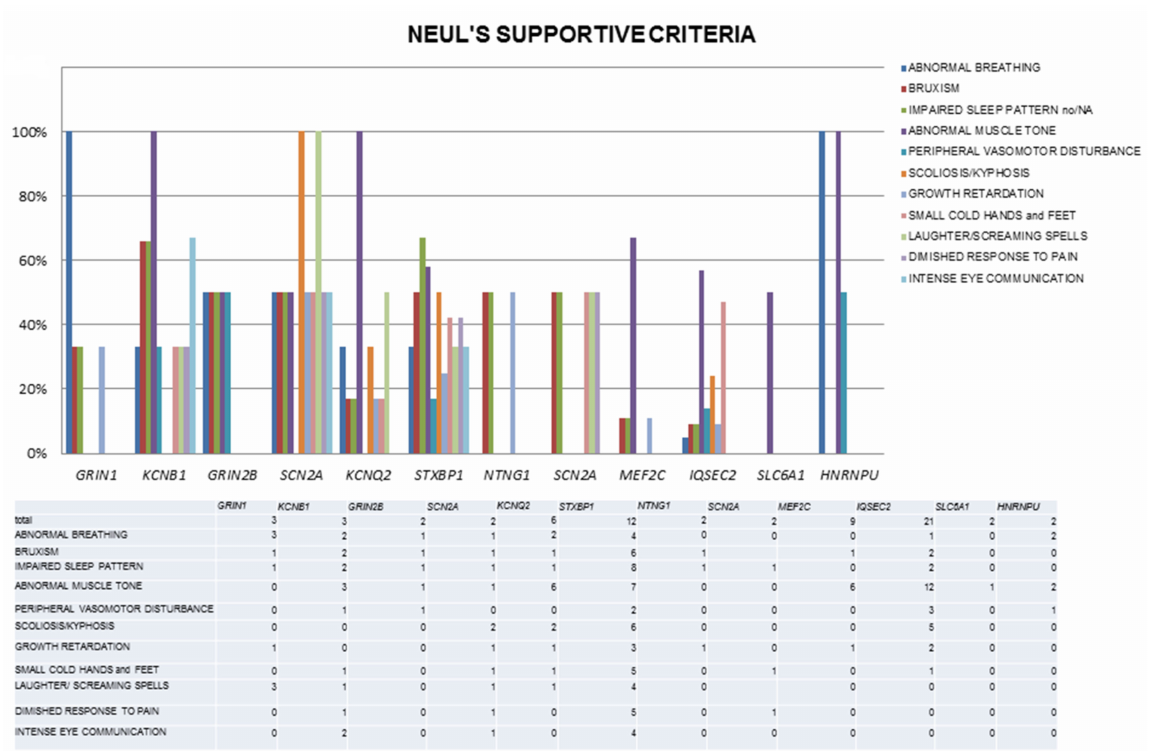
Figure 2. Neul’s supportive criteria in the cohort of reviewed cases, depicted according to genetic diagnosis (only genes with more than one reported case are